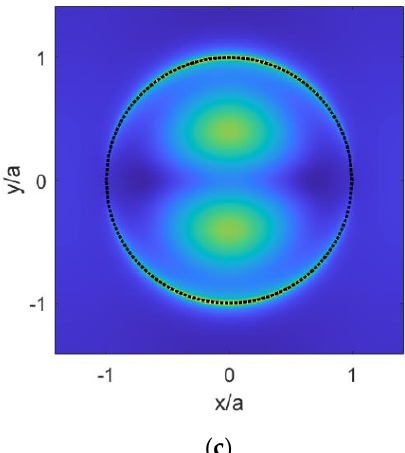
Figure 4. Near E-field behavior in the Cartesian coordinate planes of the graphene disk with a = 50 µ m, T = 300 K, t relax = 1 ps, µ c = 1 eV, at the resonance frequency f = 3.304433 THz, when a plane wave orthogonally impinges onto the disk with E 0 = E 0 ˆ y . ( a ) Near E-field in the xz plane; ( b ) Near E-field in the yz plane; ( c ) Near E-field in the xy plane.